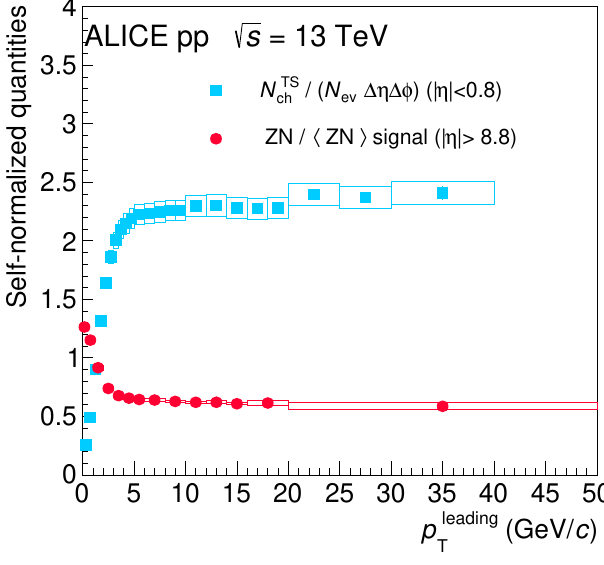
Figure 11 . Self-normalised ZN signal (red circles) and number density N ch (azure squares) distribution in the transverse region (published in ref. [38]) as a function of p leading | η | < 0.8. Tracks have p T > 0.15 GeV/c, markers are placed at the centre and not at the average of the p leading T